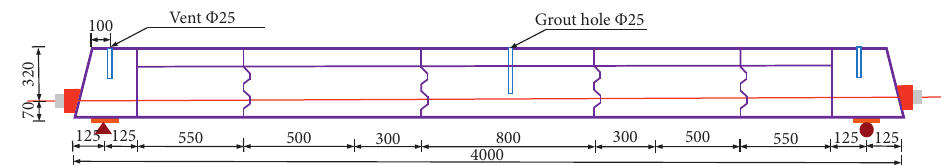
Figure 2: External tendons in specimen 6.